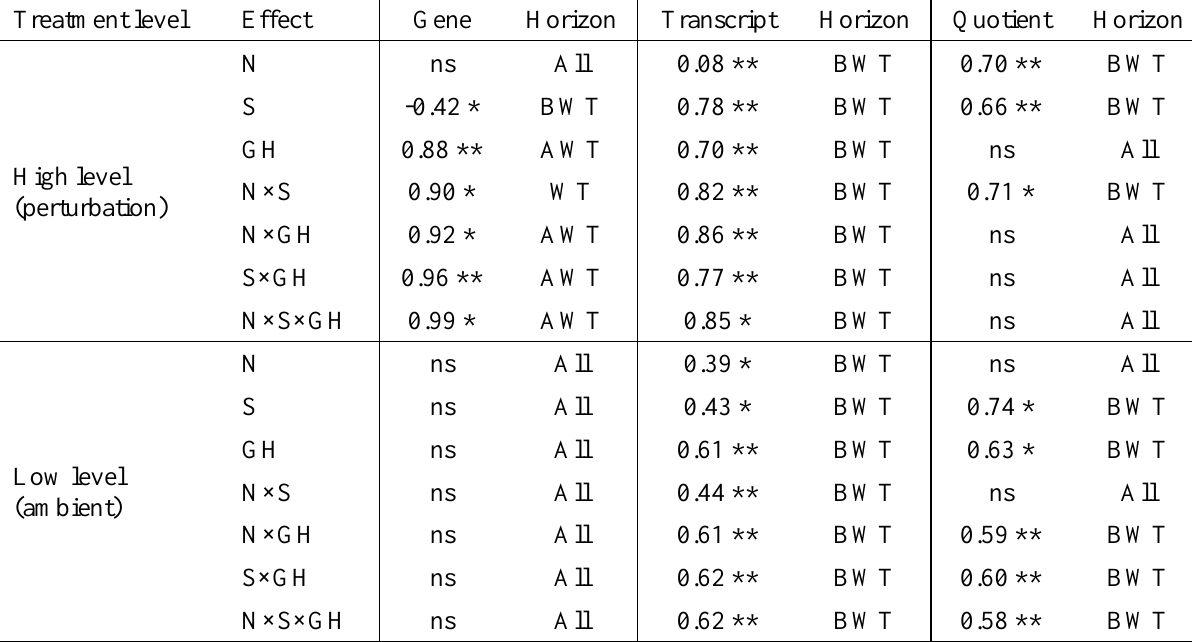
Table 1. Pearson correlation coefficients between CH production rate and mcr A gene abundance (Gene), 4 mcr A transcript abundance (Transcript) and transcript/gene quotient (Quotient) per horizon in the peat profile. Horizons: AWT = above the annual mean water table level; WT = layer around the annual mean water table level; BWT = below the annual mean water table level. All: includes AWT, WT and BWT. Significance levels are indicated as **: p ≤ 0.001; *: p ≤ 0.05; ns: